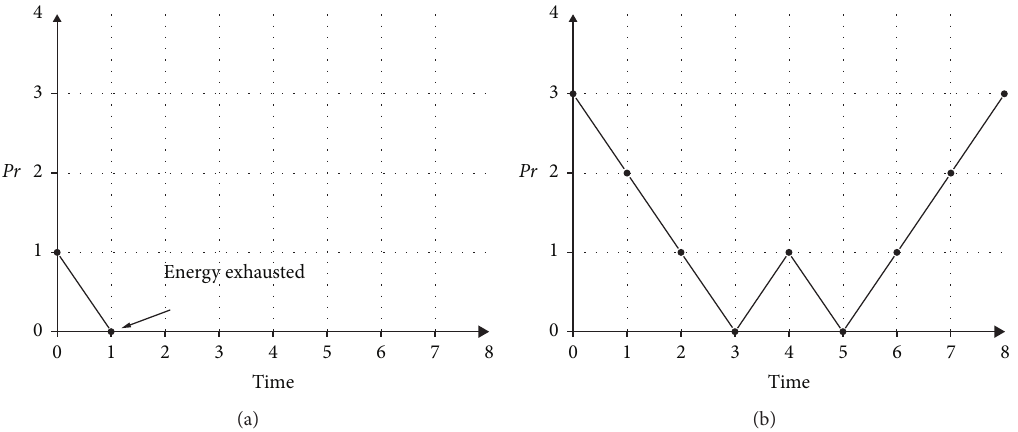
Figure 3: Energy consumption of task τ